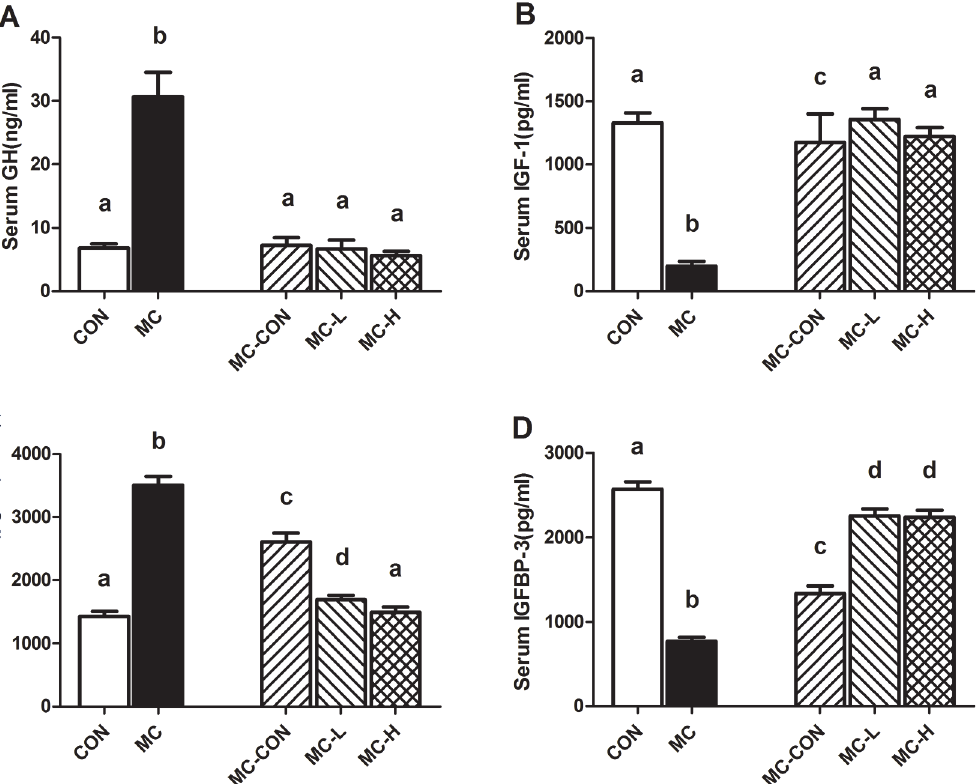
Fig 3. Serum Levels of GH, IGF-1, IGFBP-1, and IGFBP-3. GH (A), IGF-1 (B), IGFBP-1 (C), and IGFBP-3 (D) levels in each group were measured by enzyme-linked immunosorbent assay (ELISA). Values are presented as means ± standard deviation (SD). Different letters indicate a significant difference (p < 0.05). GH, growth hormone; IGF-1, insulin-like growth factor-1, IGFBP-1/-3, insulin-like growth factor binding protein-1/-3.